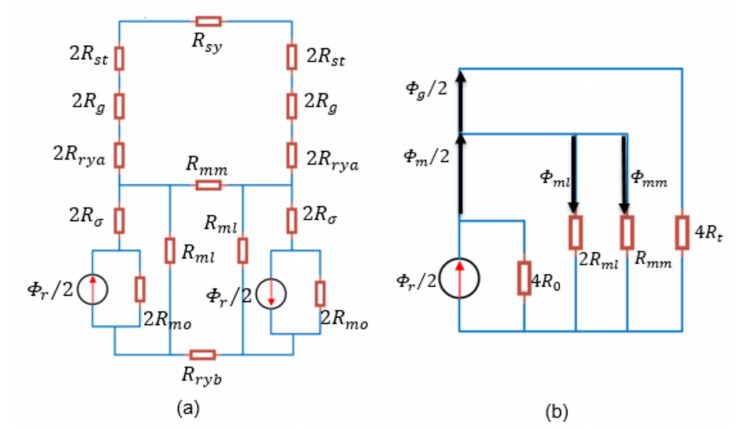
Figure 10. IPMBLDC motor with ( a ) equivalent magnetic circuit and ( b ) simplification of the equivalent magnetic